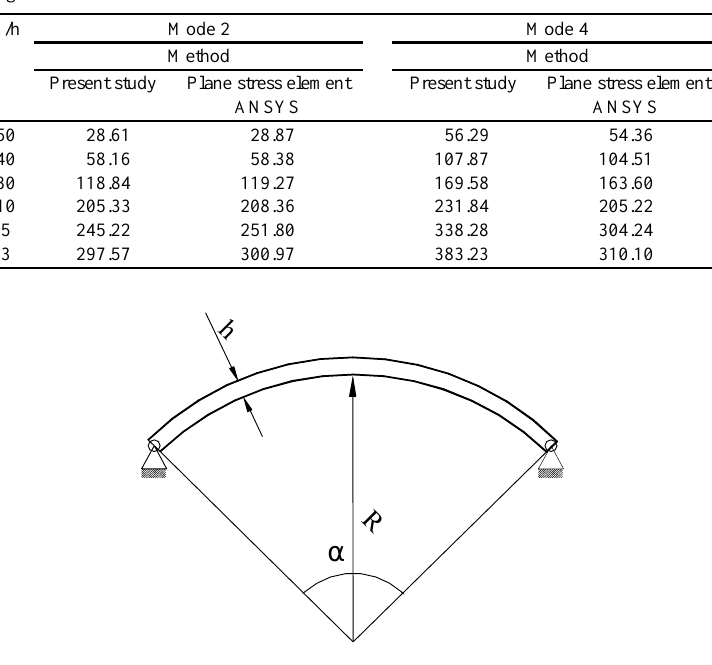
Fig. 5. A hinged circular arch with subtended angle α